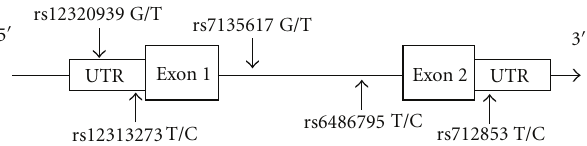
Figure 1: A graphical overview of the genotyped polymorphisms identified in relation to the exon/intron structure of ORAI1